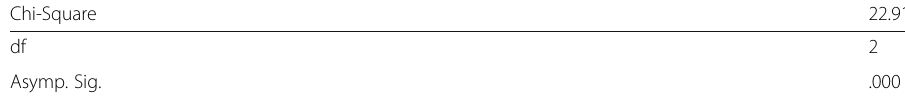
Table 7 Test statistics for the picture description task Chi-Square df 2 Asymp. Sig.